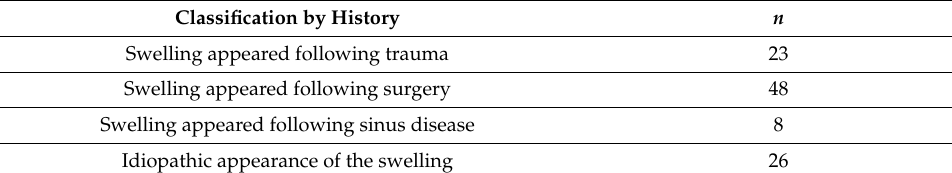
Table 3. History of appearance of suture exostosis in 105 equine cases. Classification by History